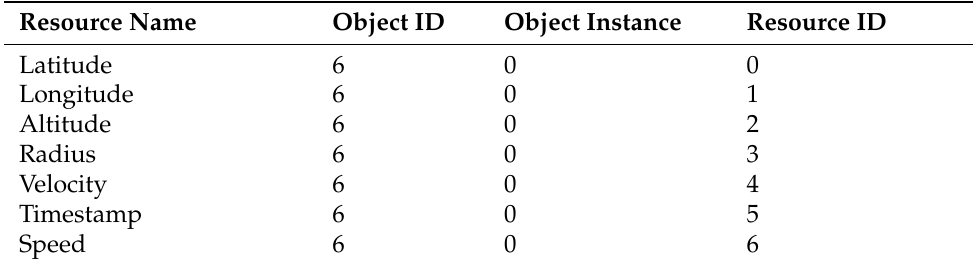
Table 2. OMA-LwM2M location object’s resources